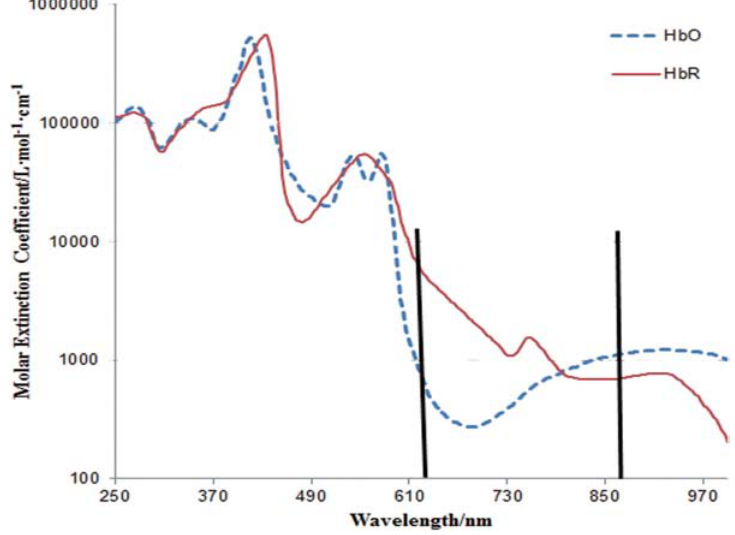
Fig. 2. The molar absorption coe±cient. Data is from the website: http://omlc.ogi.edu/spectra/hemoglobin/.